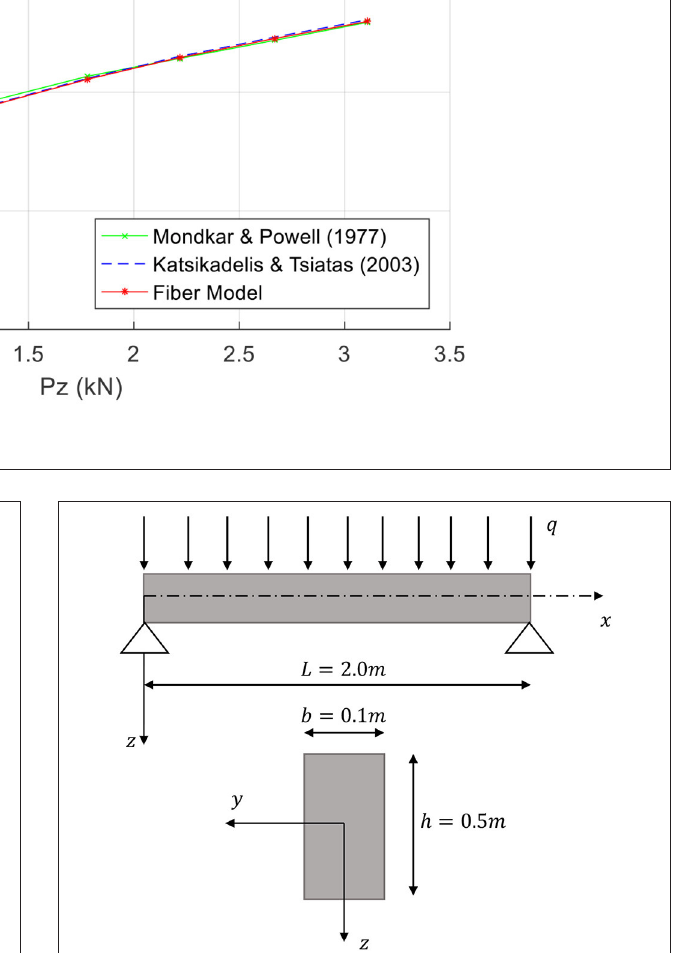
FIGURE 7 | Simply supported beam in Example